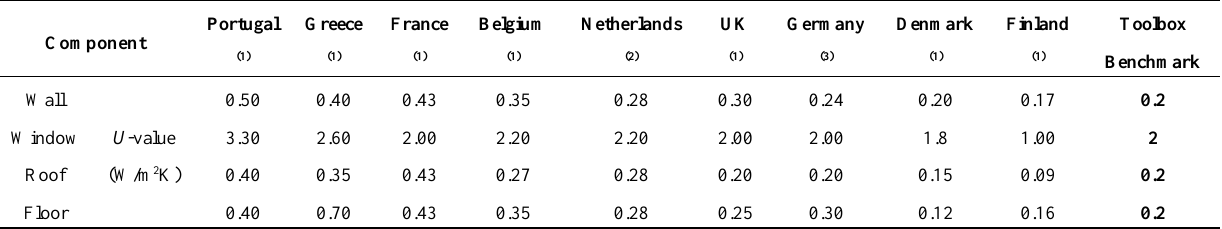
Table 2. Benchmark U -value for the building envelope, in different countries, and the toolbox